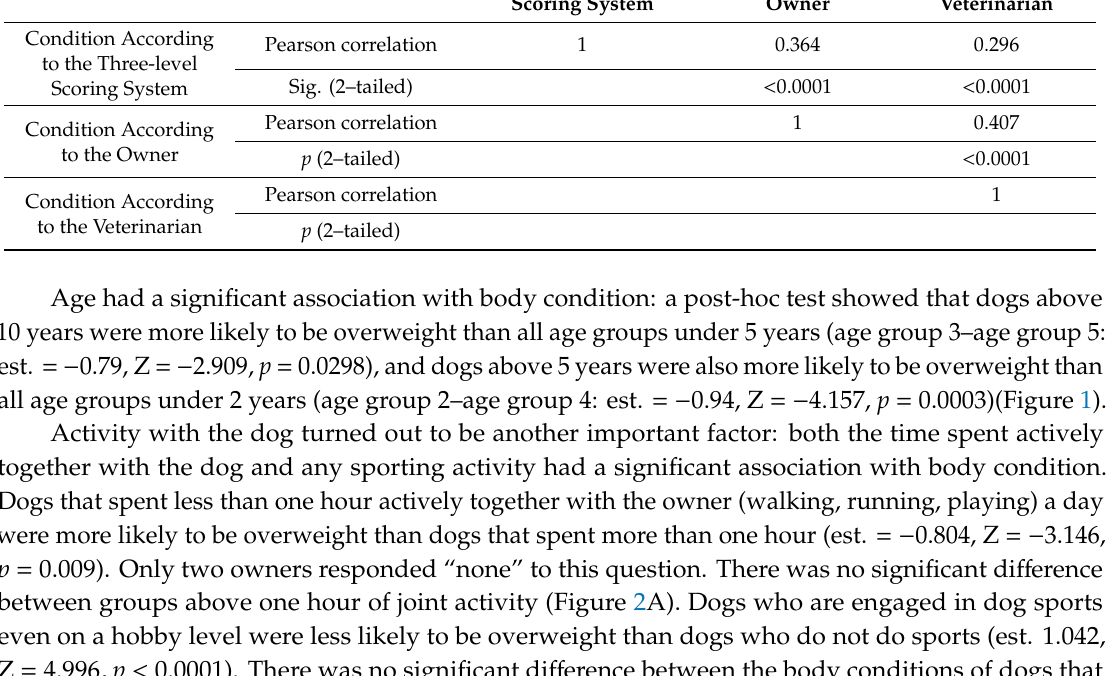
Condition According Condition Condition to the Three-Level According to the According to the Scoring System Owner